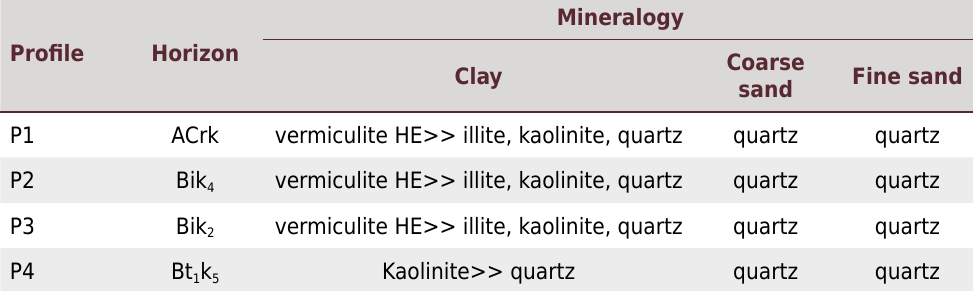
Table 8. Mineralogy of sand and clay fractions of selected